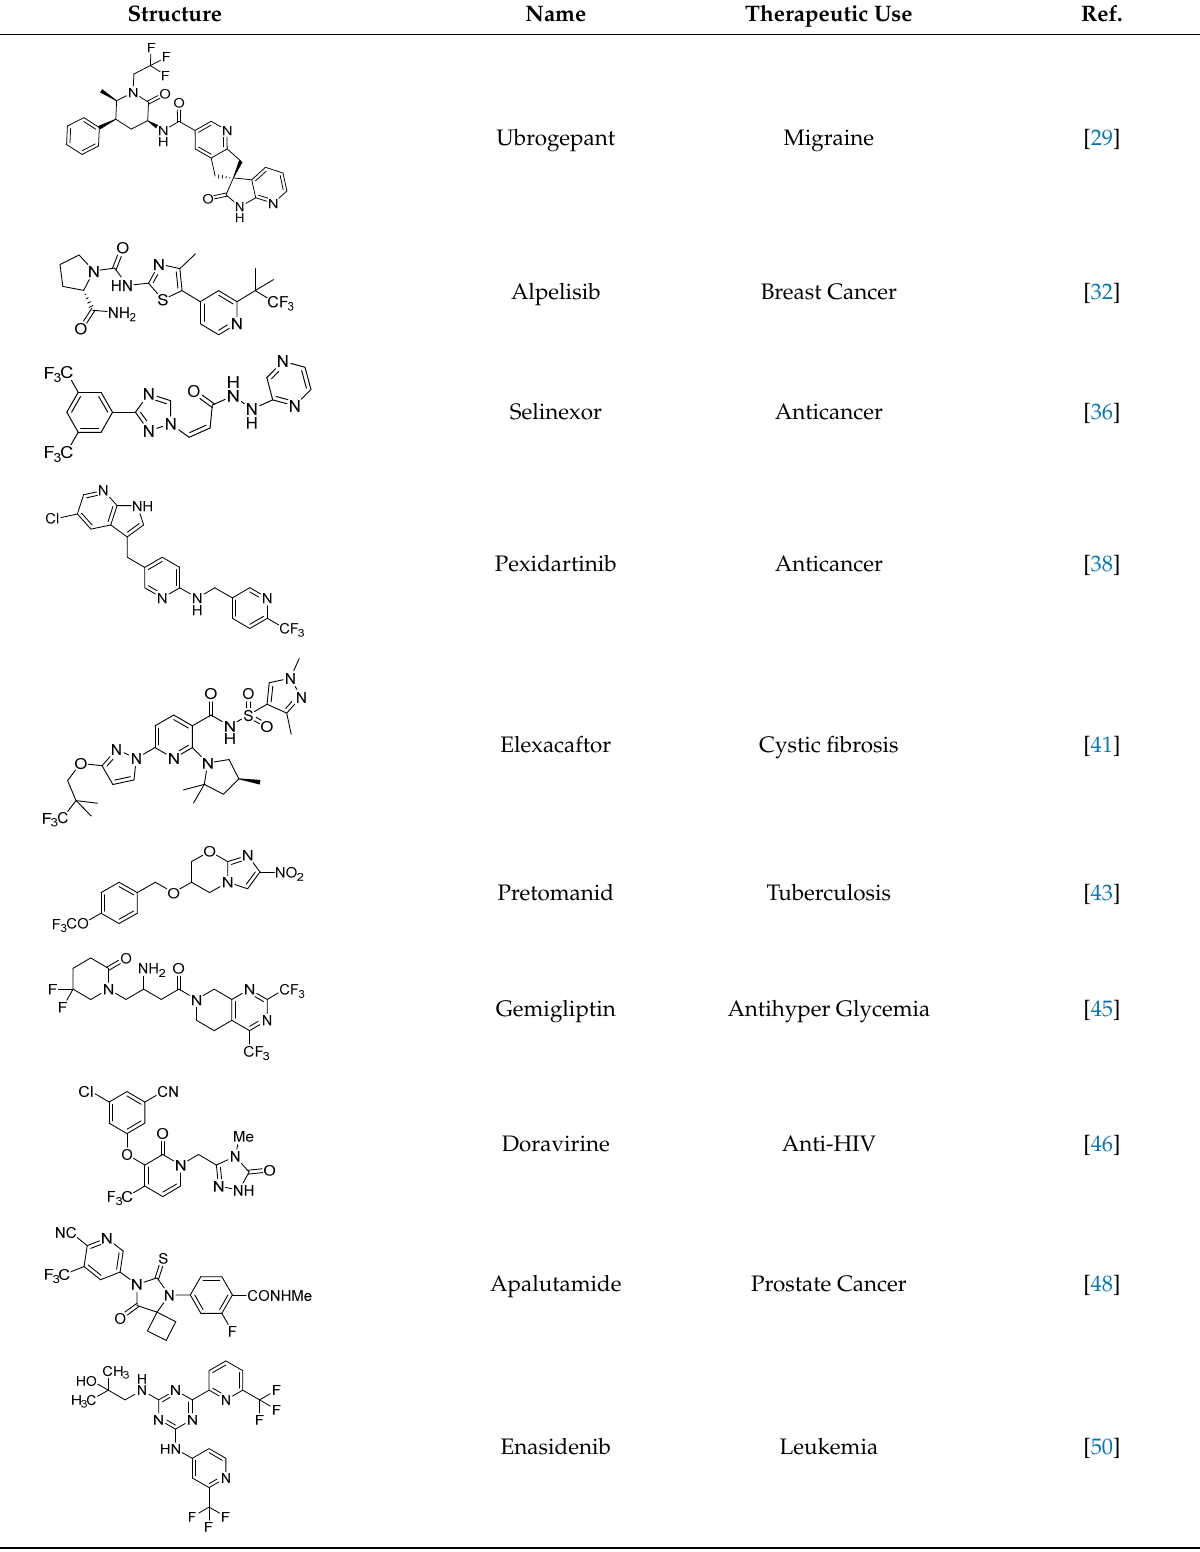
Table 1. Structures and names of trifluromethyl group containing FDA-approved drugs. Structure